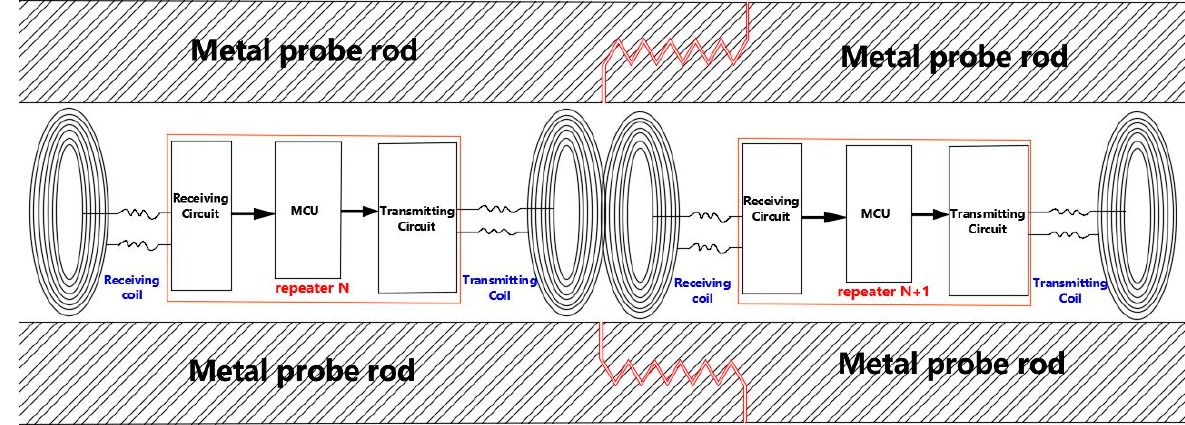
Figure 6. The composition of the repeater and the pairing method of the coil.